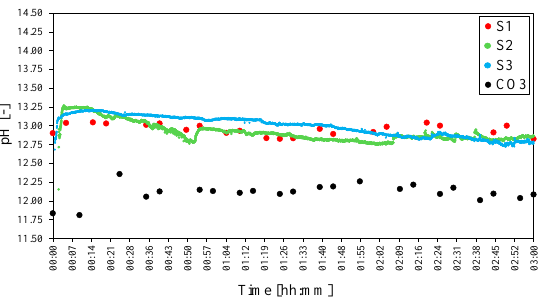
Figure 4. pHs of the standard HC LDHs S1, S2, S3 and CO3. The pH was adjusted to 25 ◦ C to facilitate